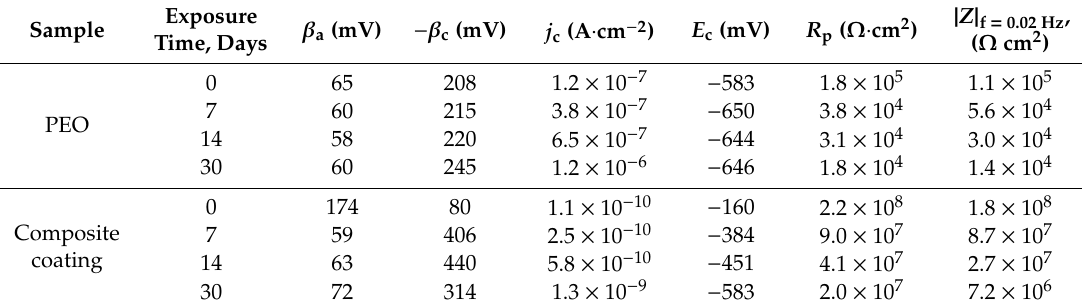
Figure 18. Potentiodynamic polarization curves obtained in 3% NaCl for PEO and composite coatings before and after 7, 14 and 30 days of marine immersion. Table 10. Electrochemical parameters of PEO and composite coatings before and after 7, 14 and 30 days of marine immersion (Figure